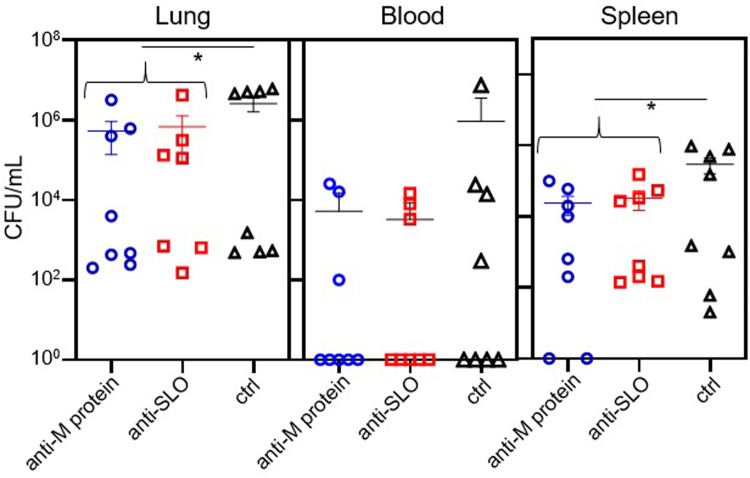
Quantification of GAS in the lungs, blood, and spleens of mice treated with antisera 2 h after superinfection.Mice were infected i.n. with 0.1 LD50 IAV on day 0 and GAS on day 7 followed 2 h later by treatment with antisera to the M protein, SLO, or non-immune sera as a control (ctrl). Mice were euthanized 24 h later and the number of GAS present in blood, lungs, and spleens was determined by dilution plating. Differences between the individual groups were not statistically significant (p > 0.05); however, there were fewer GAS in the lungs and spleen of mice treated with either antisera to SLO or the M protein compared to those treated with non-immune sera (p < 0.05; *). Statistical significance was determined with the Student's t-test.